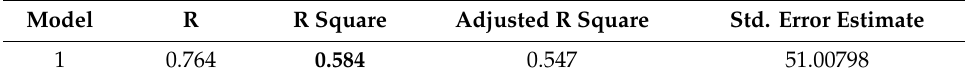
Table 18. The result of Multiple Regression Analysis for parameters from the Environmental group.